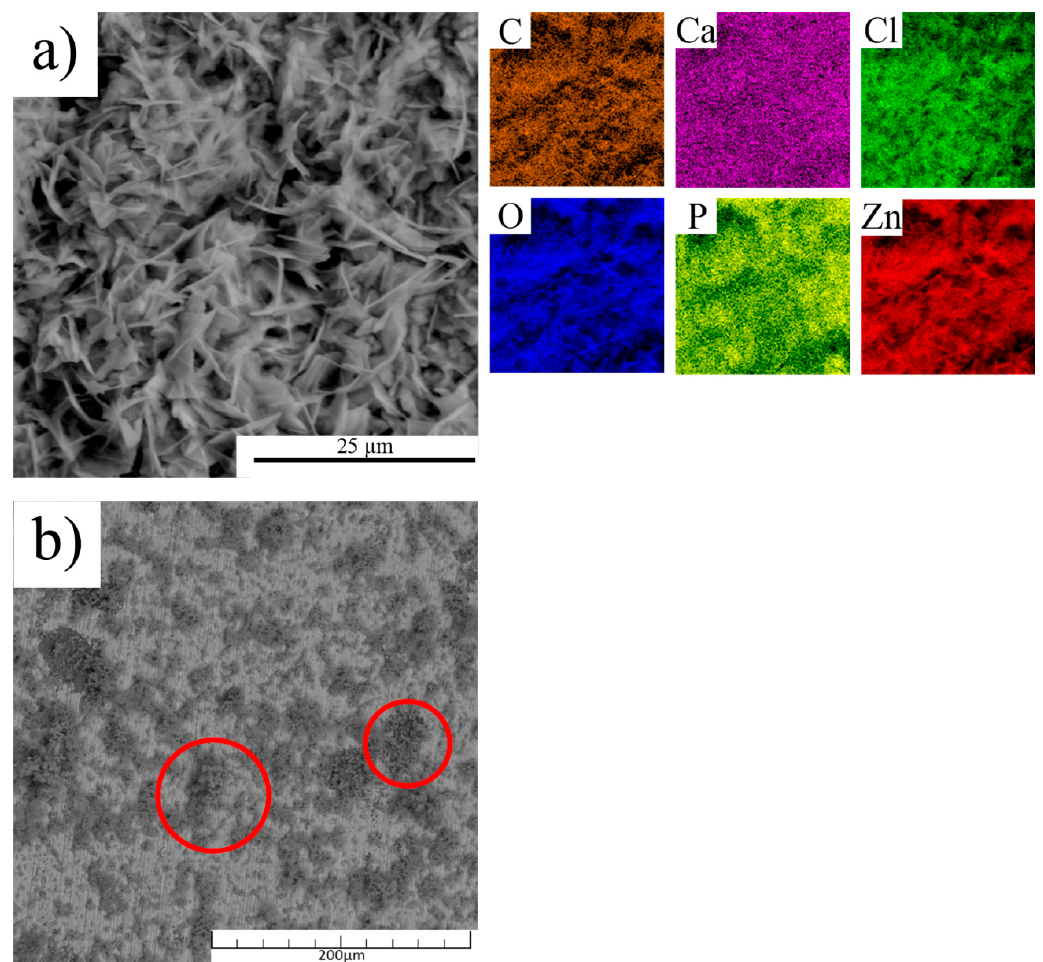
Figure 8. ( a ) The SEM image and X-ray elemental maps of corrosion products occurred predominantly on the upper layer and ( b ) SEM image showing the precipitation HA on the HA particles.